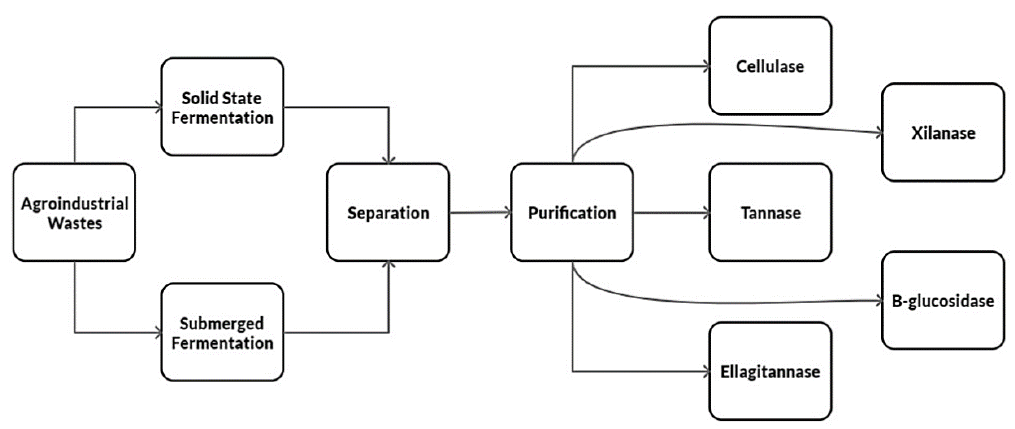
Figure 2. Diagram showing the main enzyme production processes through solid-state and submerged fermentation (original source).